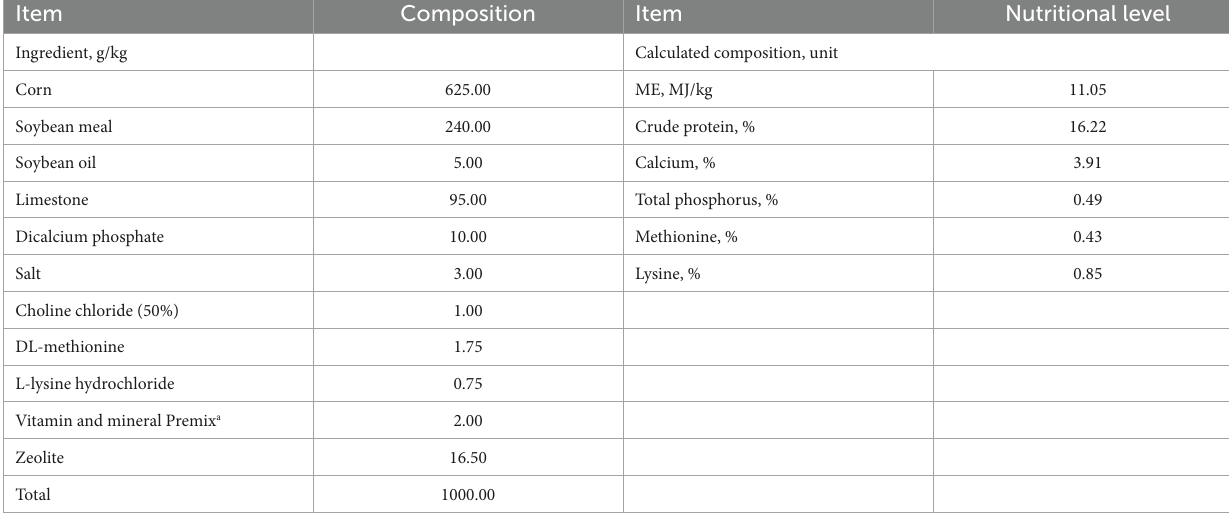
TABLE 1 The ingredient composition and nutritional level of the basal diet (as-fed